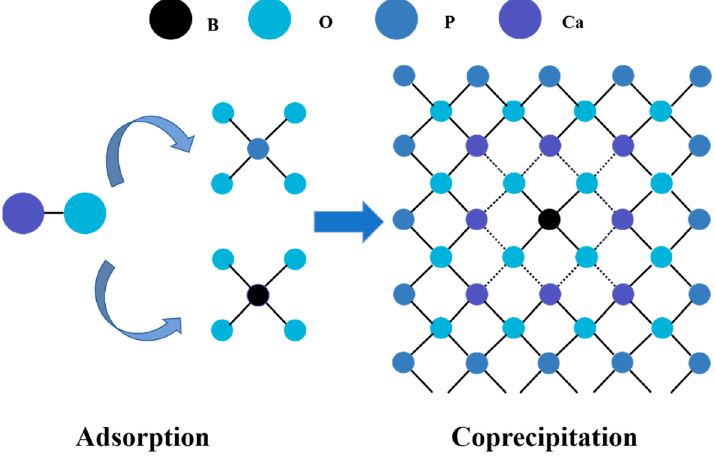
Figure 8. Schematic diagram of B removal mechanism by COS under the intervention of phosphorus (circle in black, light blue, deep blue, and purple represents B, O, P and Ca, respectively).